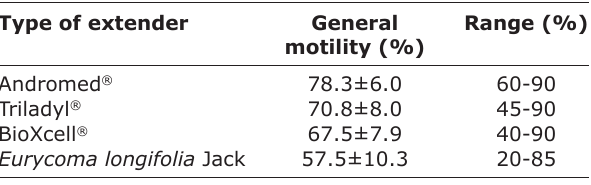
Table-3: General motility mean±SEM (%) of Rusa deer postequilibration for 4 h, at 4°C with different extenders.